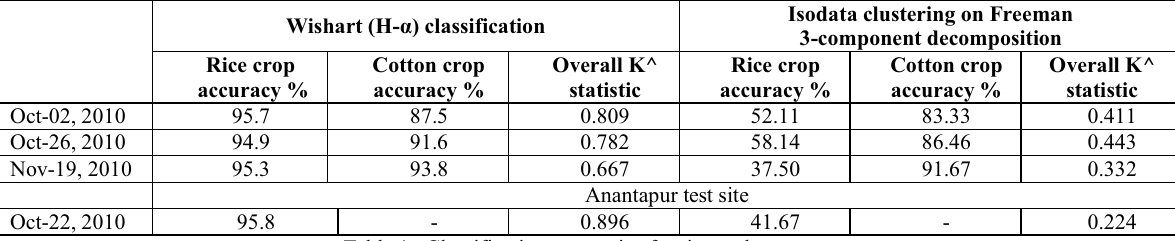
Table 1. Classification accuracies for rice and cotton